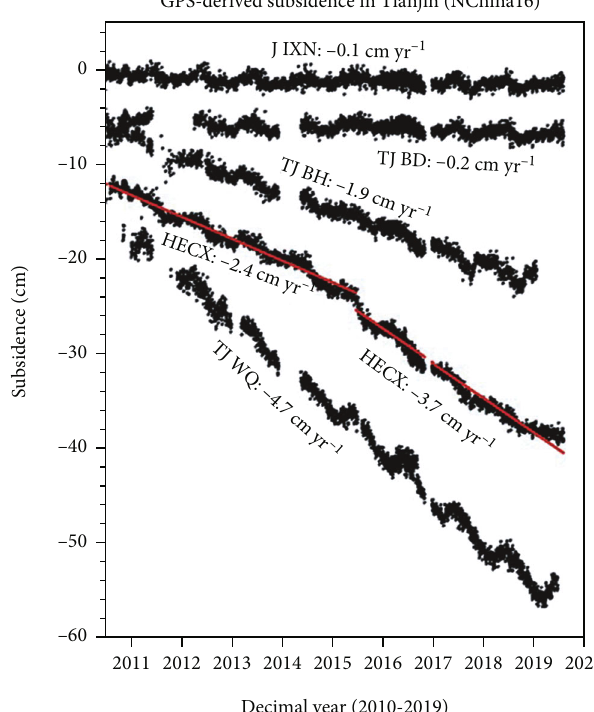
Figure 10: Subsidence recorded by 4 GPS stations (JIXN, TJBD, TJBH, and TJWQ) within one GPS station (HECX) adjacent to the Tianjin City from the year 2011 to 2020